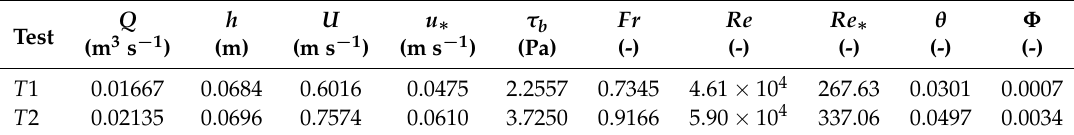
Table 1. Hydraulic parameters characterizing the mean